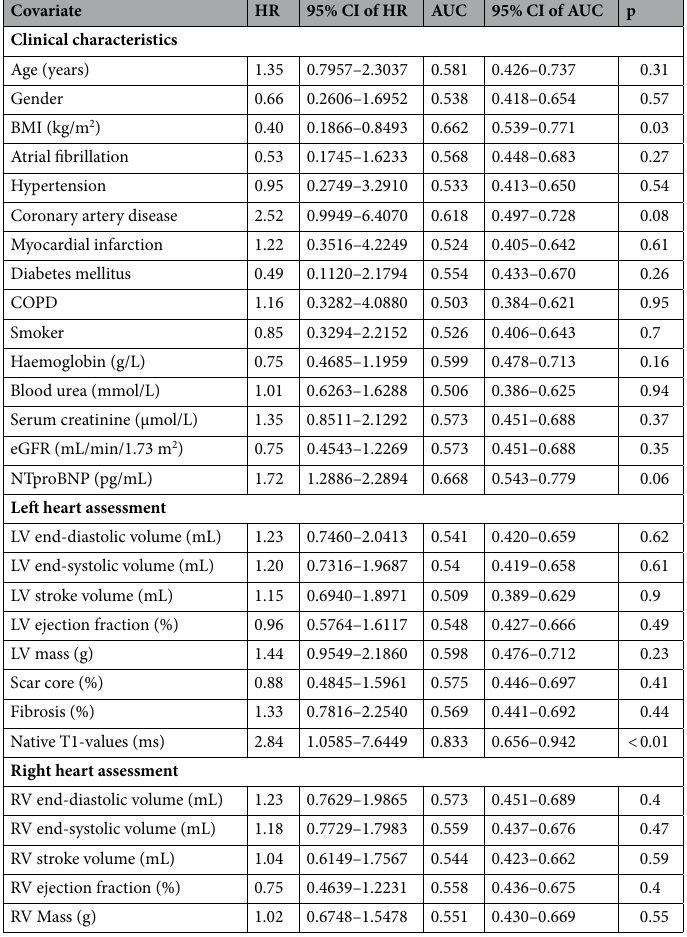
Table 5. Univariate regression and receiver operator characteristics (ROC) results for the study cohort excluding amyloid